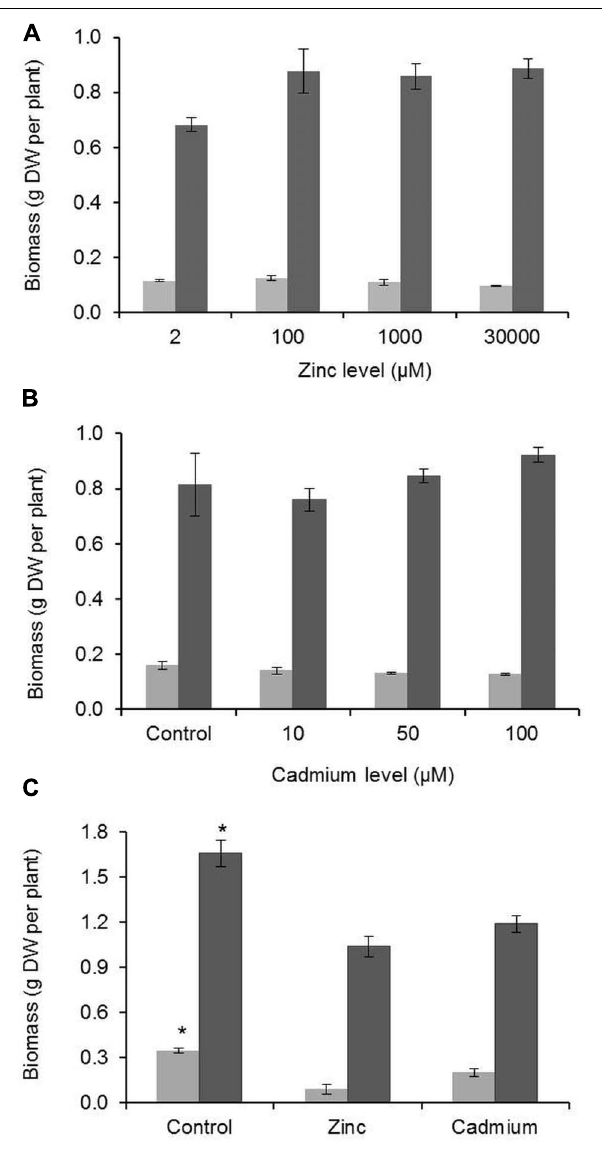
FIGURE 3 | Root (light gray bars) and shoot (dark gray bars) biomass of G. claussenii (A,B) and G. elegans (C). G. claussenii plants were exposed to different zinc (Zn; 2–3000 μ M) and cadmium (Cd; 0–100 μ M) concentrations and G. elegans plants were exposed to normal Zn (2 μ M), high Zn (100 μ M) and Cd (5 μ M), for 3 weeks. Data points and error bars represent mean values ( n = 3) and standard errors, respectively. DW, dry weight. Asterisks denote significant differences of control (2 μ M Zn) from treatments as found uponTukey’s testing ( P < 0.05).